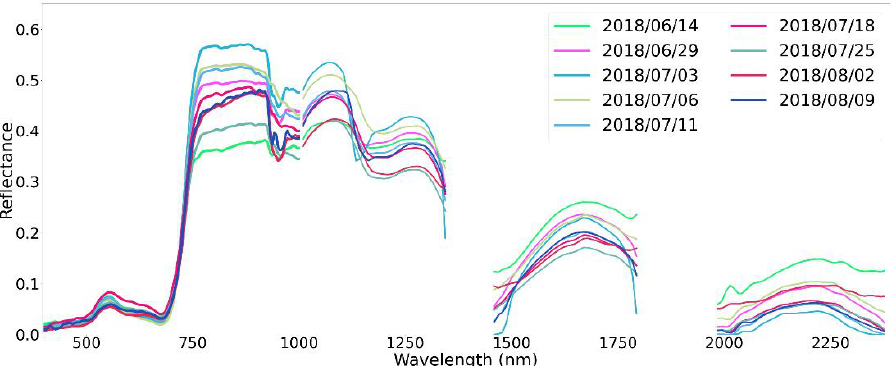
Figure 6. Example of reflectance of one of the varieties in HyCal-18 experiment (“Trudan 8”) during the 2018 growing season.